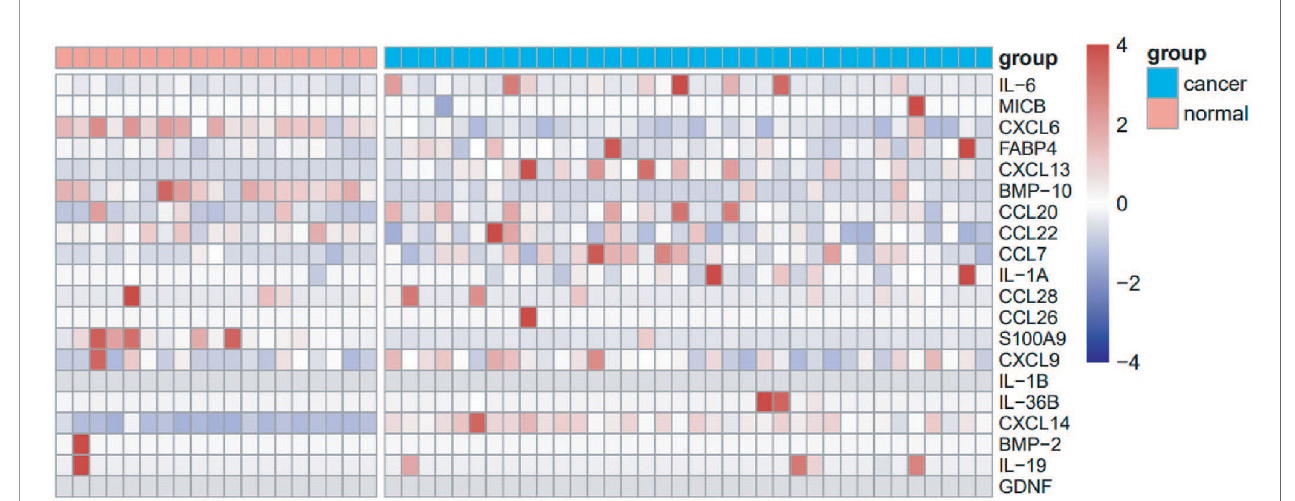
FIGURE 1 | Screening of cytokines using the multiplex Luminex System. Heat map showing the expression level of 20 cytokines in the plasma of 36 patients with lung cancer and 19 healthy